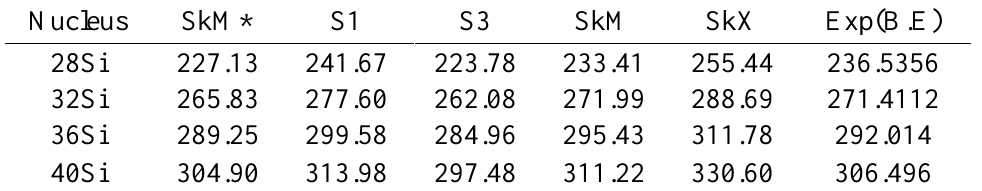
Table 3: The calculated values of Binding energy compared with experimental values taken from Ref.